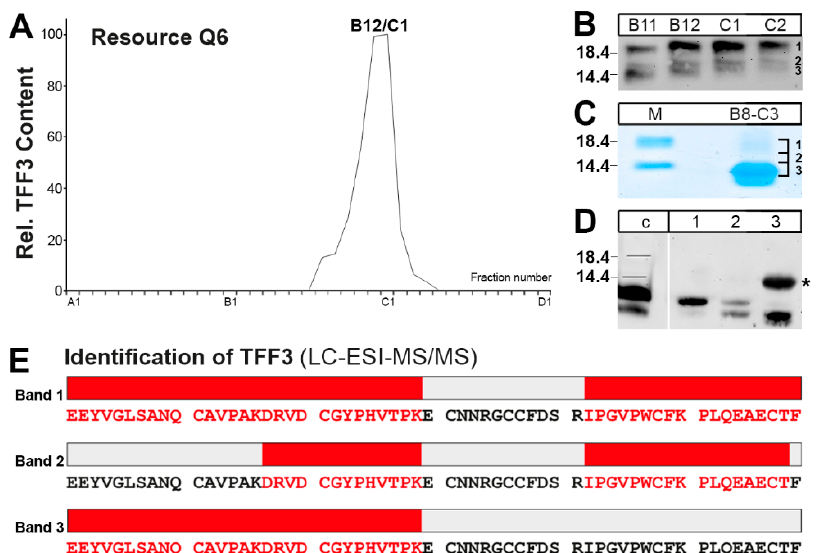
Figure 3. Purification of different forms of TFF3 from saliva and characterization by LC-ESI-MS/MS analysis. ( A ) Saliva of a single individual (S-20) was purified via SEC on a Superdex 75HL column (analogous to Figure 1) and then the low-molecular-mass region (about fractions C8-D5) subsequently separated by anion exchange chromatography on a Resource Q6 column. Shown is the distribution of the relative TFF3 immunoreactivity in the fractions as determined by Western blot analysis under reducing conditions and semi-quantitative analysis of the typical 7k-band intensities (monomeric TFF3). Fractions B8-C3 were concentrated, desalted and further analyzed. ( B ) 15% SDS-PAGE under non-reducing conditions of fractions B11–C2 (see ( A )) and subsequent Western blot analysis concerning TFF3 (marked are bands 1-3). ( C ) Separation of combined fractions B8-C3 (see ( A )) by non- reducing 15% SDS-PAGE followed by Coomassie staining. Marked are the bands excised (1, 2, 3) and subjected to Western blot analysis under reducing conditions or LC-ESI-MS/MS analysis. ( D ) Separation of the excised bands 1, 2, and 3 (see ( C )) by 15% SDS-PAGE under reducing conditions